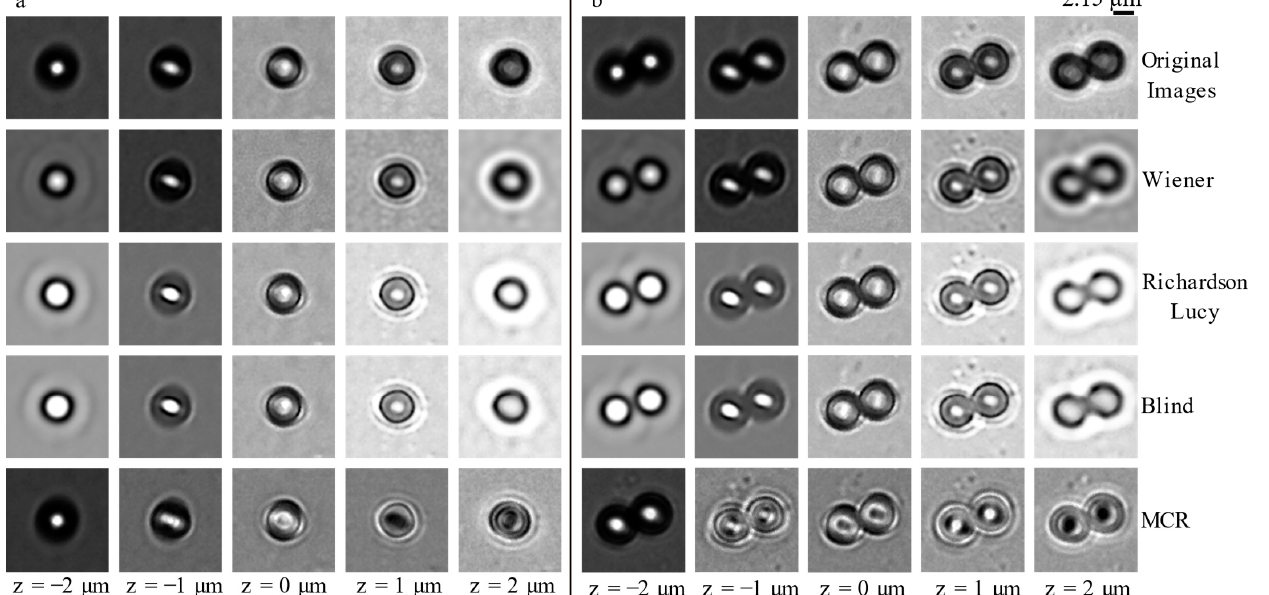
Figure 5. Original, Wiener filtering, Richardson–Lucy, blind deconvolution, and MCR images of a single silica microbead ( a ) and a pair of silica microbeads ( b ).